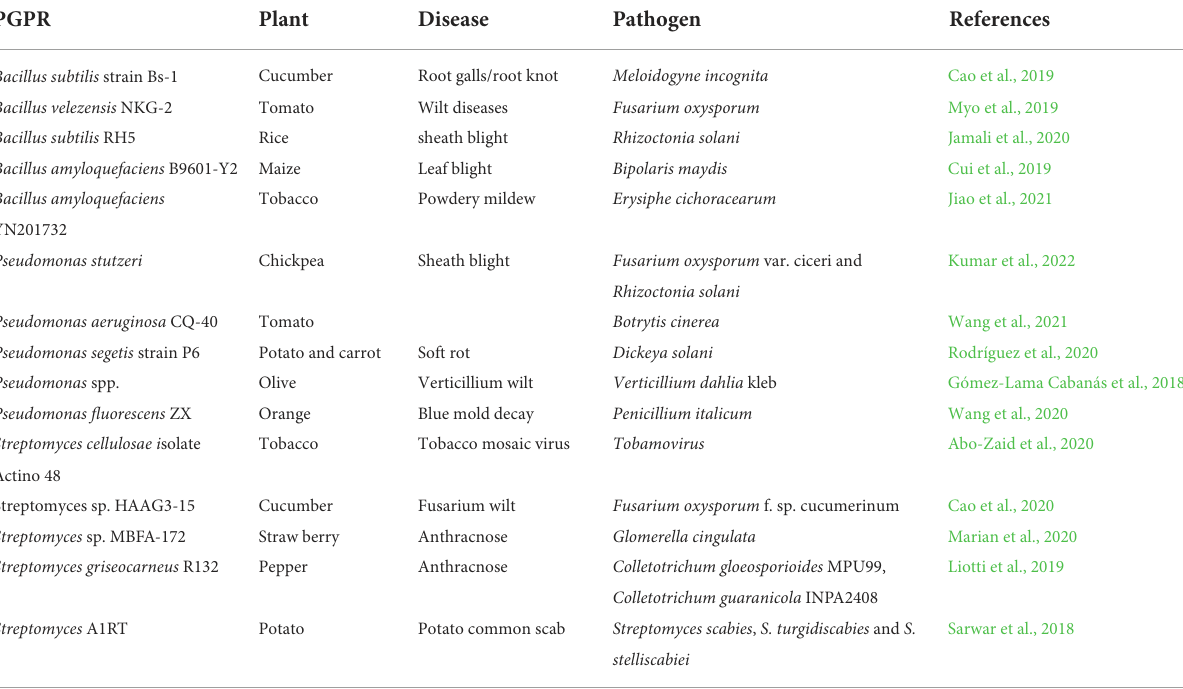
TABLE 1 Biocontrol activities of Bacillus spp., Pseudomonas spp., and Streptomyces spp. on various